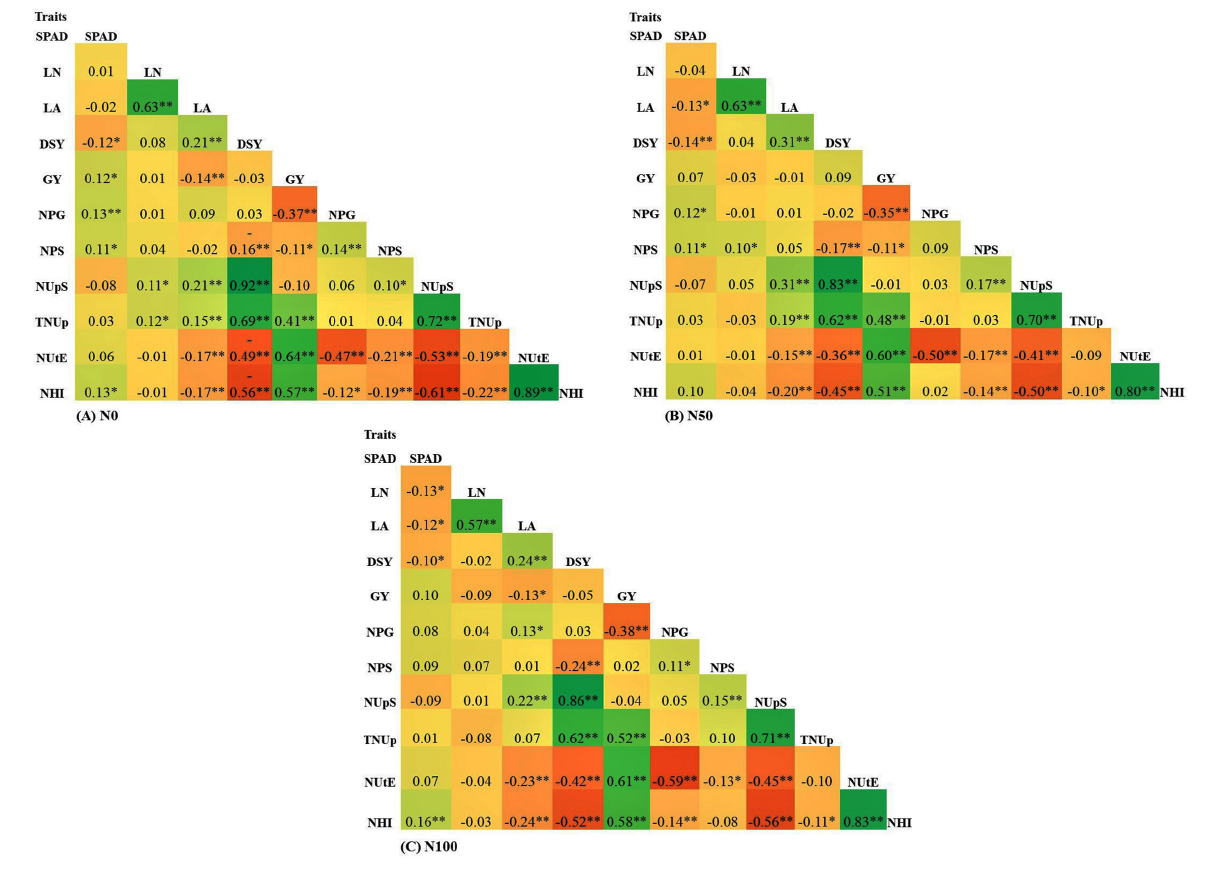
FIGURE 6 | Pearson correlation for traits underlying NUE in 380 global diverse pearl millet genotypes (PMiGAP) under three different nitrogen (N) regimes carried out in 2017/18 (data pooled from two summer seasons). (A) Correlations among eight traits at N 0 condition (N 0 ). (B) Correlations among eight traits at N 50 condition. (C) Correlations among eight traits at N 100 condition. ∗ indicates < 0.05 significance, ∗∗ indicates < 0.01